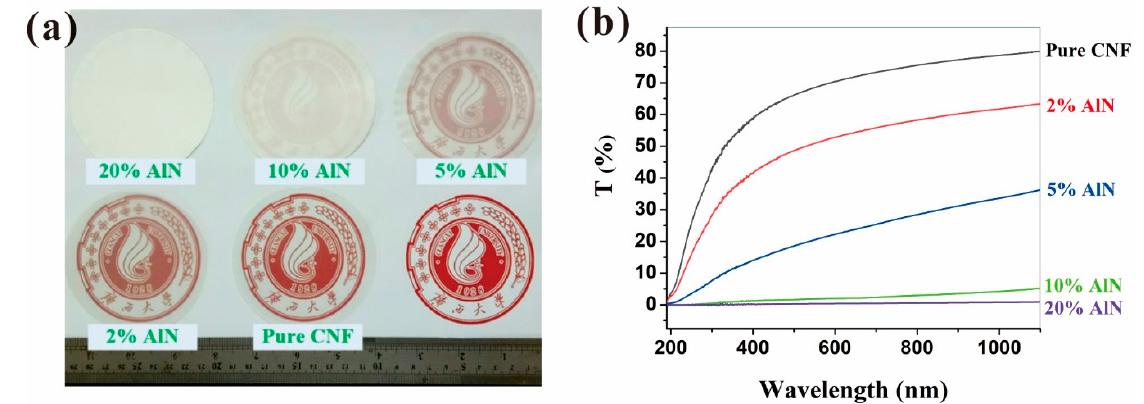
Figure 3. Optical properties of CNF-AlN composites: ( a ) Optical images and ( b ) transmittance.